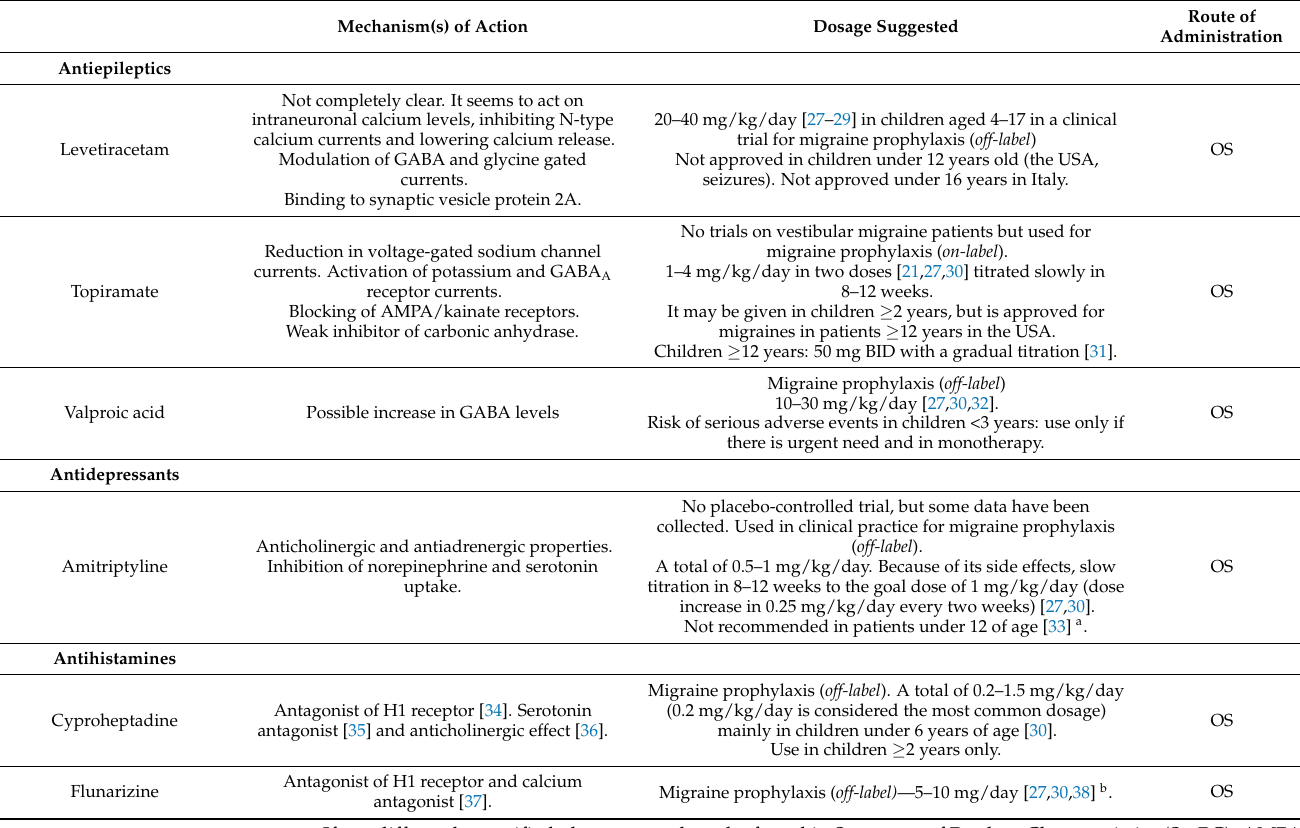
Table 1. Drugs used or evaluated in vestibular migraine and recurrent vertigo of childhood ( off-label , part